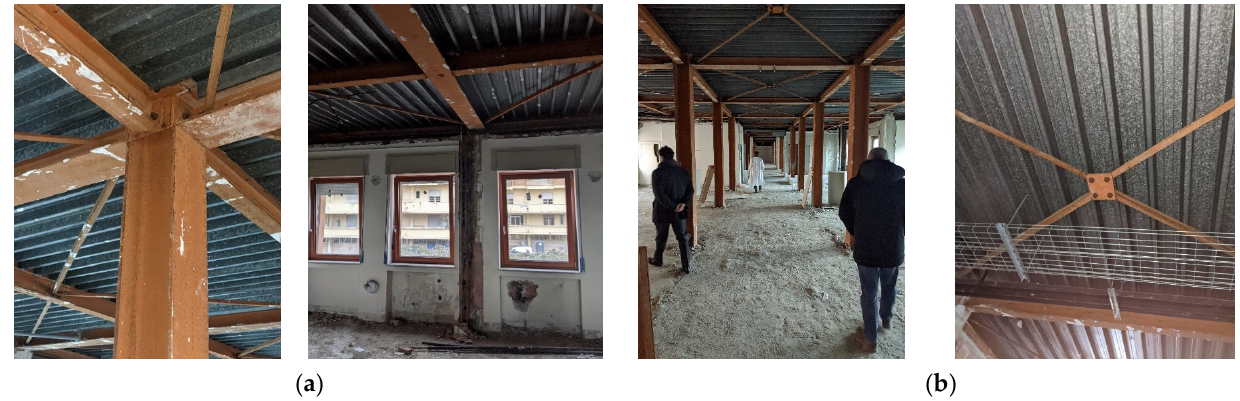
Figure 4. Construction details: bolted connections between columns and beams ( a ); horizontal concentrically bracing system ( b ).